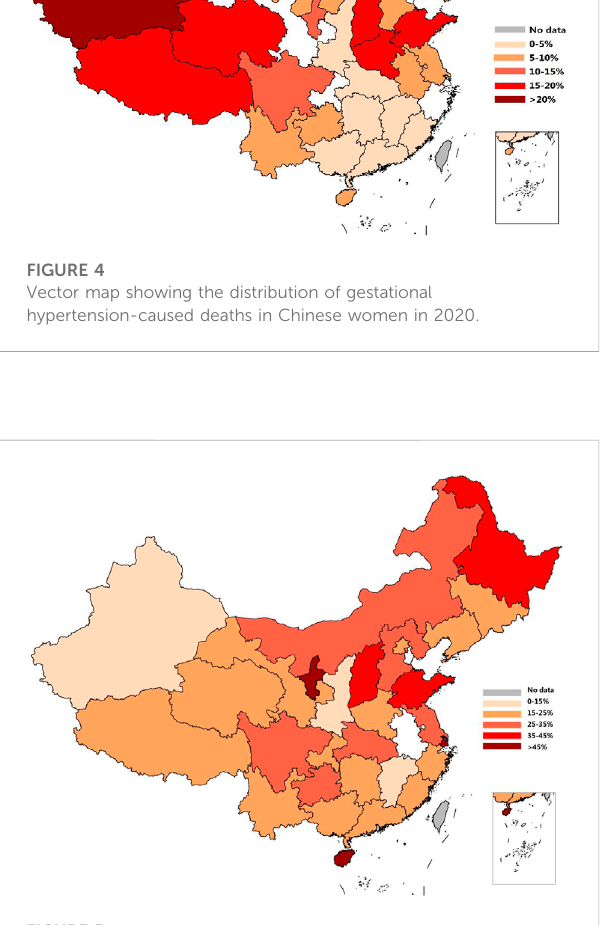
FIGURE 5 Vector map showing the distribution of medical comorbidities causing death in Chinese individuals in